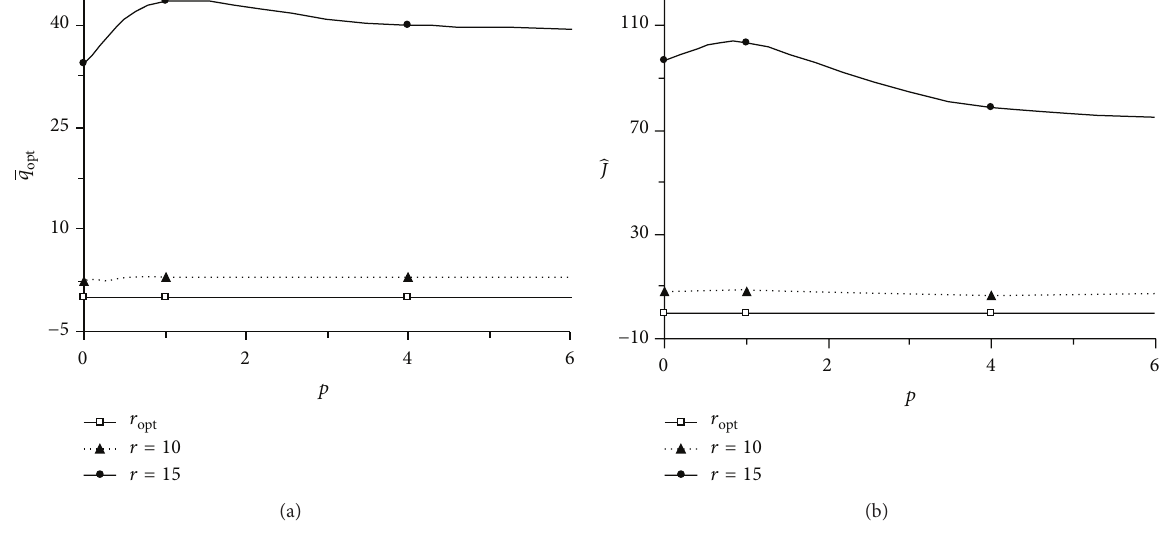
̂𝐽 and the energy for SSSS plates with 𝑎/𝑏 = 1 . opt